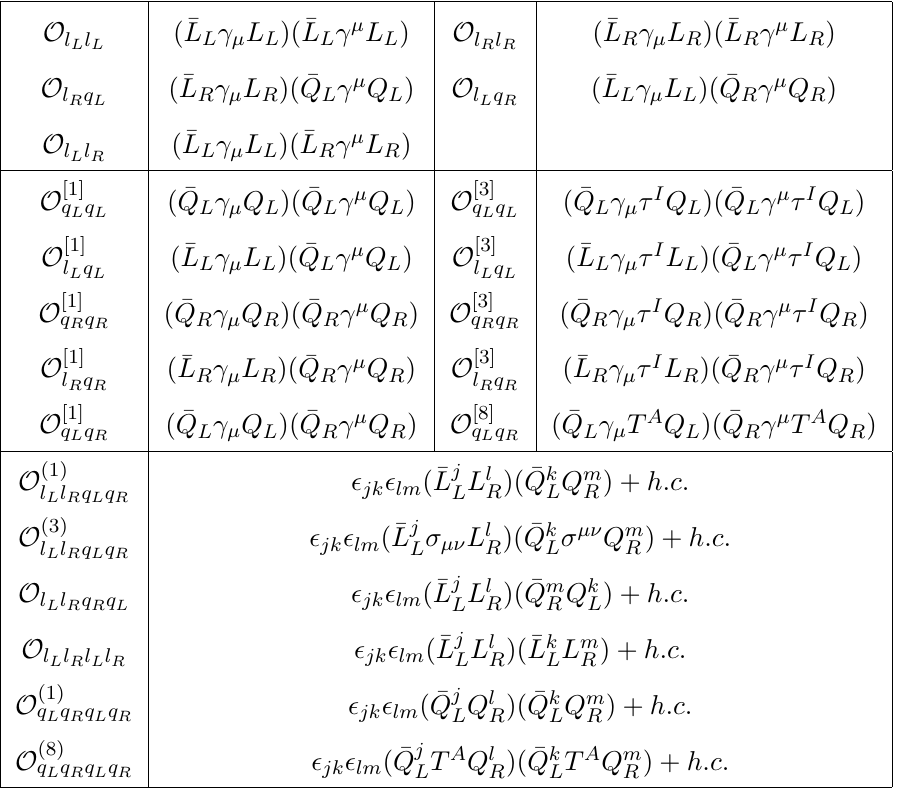
Table 19. MLRSM: Baryon Number Conserving 4 [15 + 6